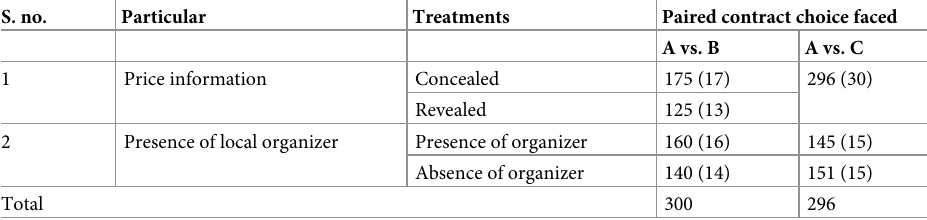
Table 3. Number of subjects and experiment sessions under different